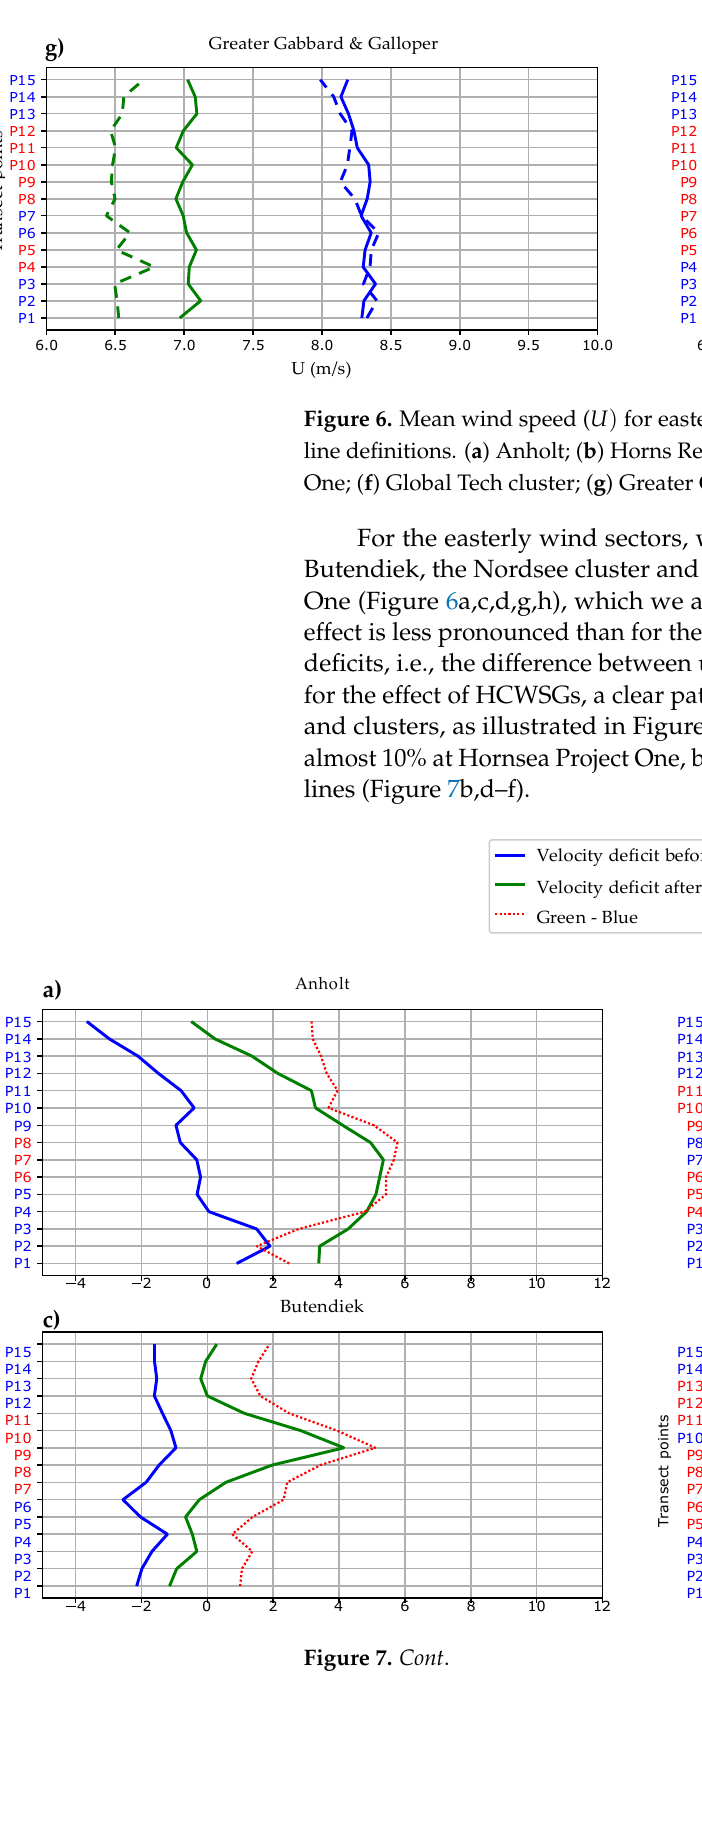
Figure 7. Velocity deficit ( 𝛥𝑈) for easterly winds over the OWFs and clusters. See Figure 5 for the definitions of lines. ( a ) Anholt; ( b ) Horns Rev cluster; ( c ) Butendiek; ( d ) Nordsee cluster; ( e ) East Anglia One; ( f ) Global Tech cluster; ( g ) Greater Gabbard & Galloper; ( h ) Hornsea Project One. T r a n s e c t p o i n t s